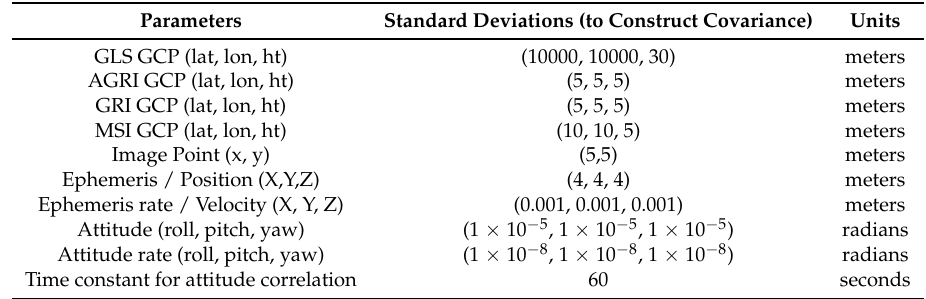
Table 2. Standard deviations used to determine the weights or a priori covariance in the space-based triangulation method. Note that the AGRI and GRI GCPs were heavily weighted (small Standard Deviation (STD)) to add constraints to the bundle adjustment so that most of the adjustments are imparted to the Global Land Survey (GLS) GCPs.